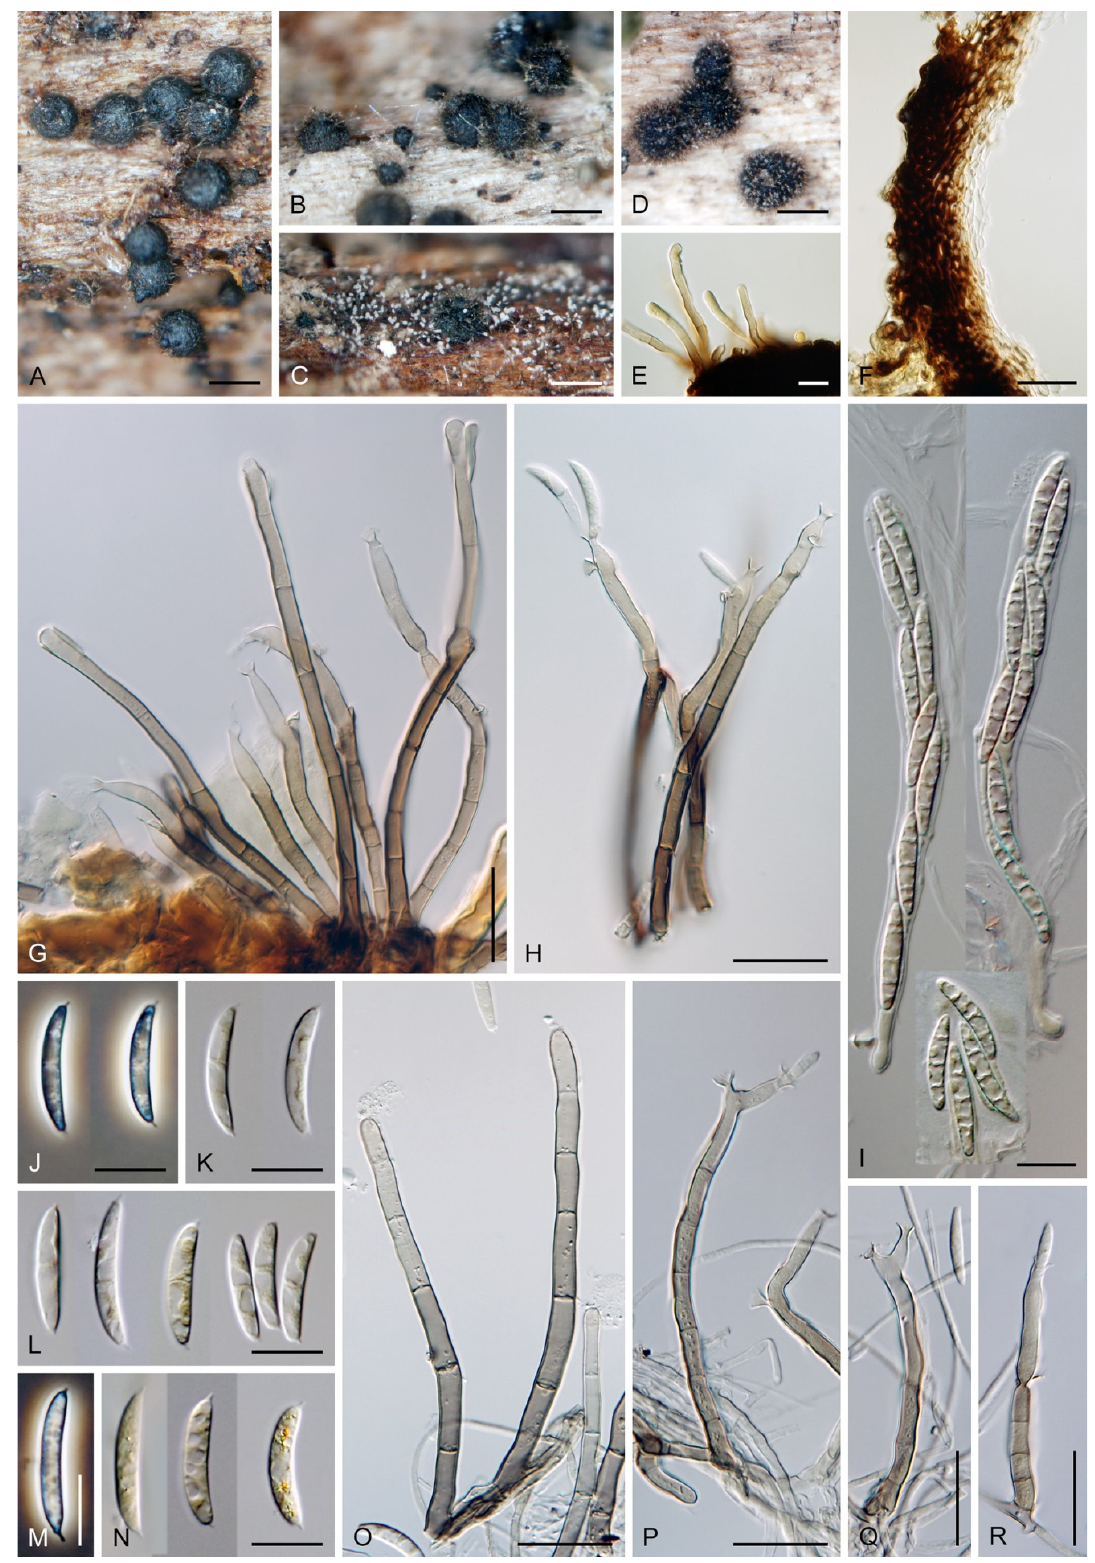
Figure 36. Stilbochaeta brevisetula . ( A – D ) Ascomata ( E ) setae on the ascomal wall ( F ) vertical section of the ascomal wall ( G , H , O – R ) setae and conidiophores ( I ) asci with ascospores ( J – N ) conidia. Images: ( A – K ) from nature ( L – R ) on MLA after 6–8 weeks ( A , L ) from ICMP 22548 ( B–E , G , H , J , K ) from ICMP 22549 ex-epitype ( F , I , M , N , R ) from ICMP 22551 ( O – Q ) from ICMP 22552. Scale bars: ( A – D ) 250 μ m; ( E – H,O – R ) 20 μ m; ( I – N ) 10 μ m.